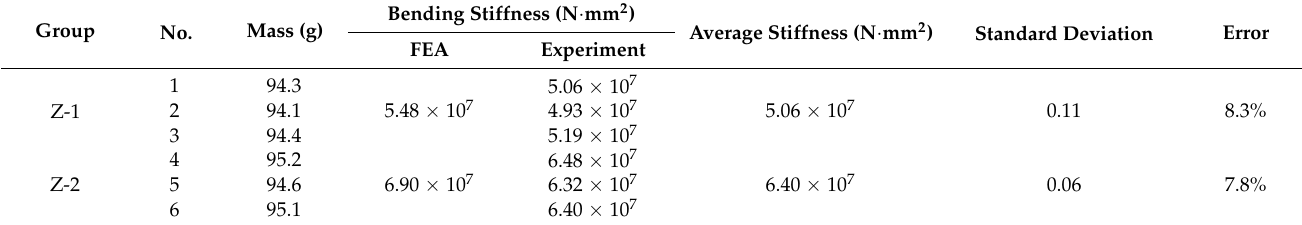
Table 5. Testing results of bending stiffness.